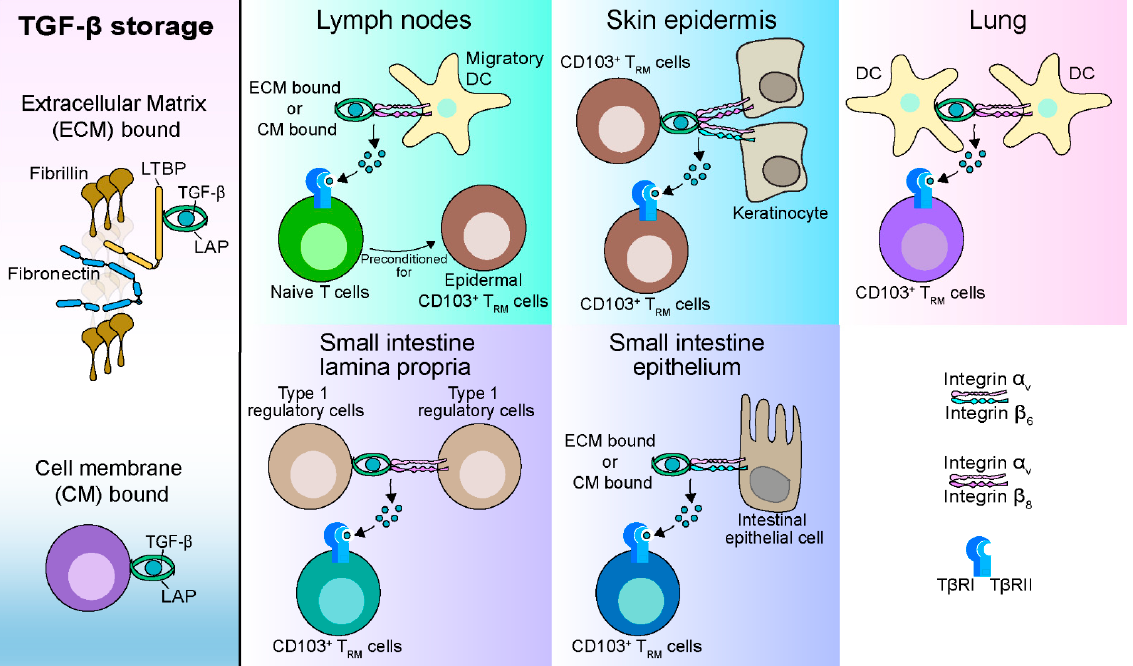
Figure 1. Integrin-mediated activation of TGF- β in the development and maintenance of CD103 + CD8 T RM cells. TGF- β is secreted as LAP-TGF- β latent complex, which binds to the latent TGF- β binding protein (LTBP) to form the large latent complex. The large latent complex can bind to extracellular matrix (ECM) proteins such as fibronectin and fibrillin to facilitate the deposit and storage of TGF- β into the ECM. Alternatively, LAP-TGF- β latent complex can also be deposited and stored on the surface of cell membranes. The activation of TGF- β requires the release of TGF- β from the LAP-TGF- β latent complex. The best understood mechanism is through integrin α v β 8 and α v β 6 . During homeostasis in the lymph nodes, α v β 8 expressed by migratory dendritic cells (DC) activates and presents TGF- β to precondition native CD8 T cells for epidermal CD103 + CD8 T RM cell residency. In the skin epidermis, α v β 8 and α v β 6 expressed by different keratinocytes activate CD8 T RM cell-derived TGF- β that is critical for the development and maintenance of CD103 + CD8 T RM cells. In the small intestine lamina propria, type 1 regulatory cells promote CD103 + CD8 T RM cell development by producing TGF- β and activating it through the expression of α v β 8 . In the small intestine epithelium, intestinal epithelial cells express α v β 6 , which is required for the activation of TGF- β and CD103 + CD8 T RM cell development and maintenance. In the lung, DC membrane bound TGF- β and DC expressing α v β 8 efficiently drive CD103 + CD8 T RM cell